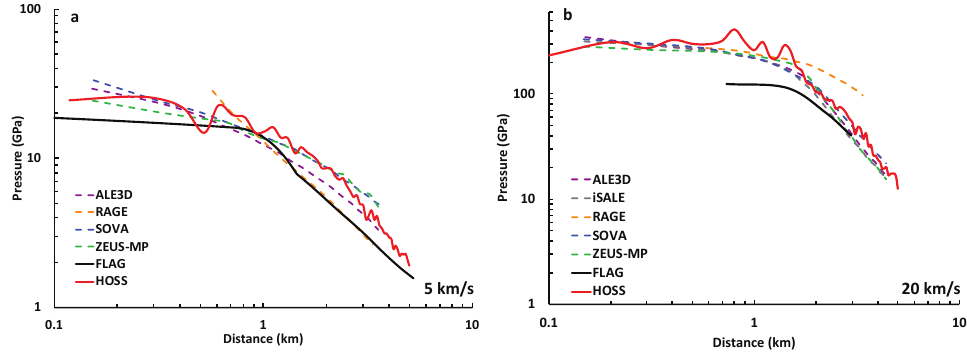
Figure 12. 3D oblique impact (45 ◦ from vertical), diagonal tracers from FLAG and HOSS simulations, plotted with data from Pierazzo et al. [5] for ( a ) 5 km/s impact and ( b ) 20 km/s